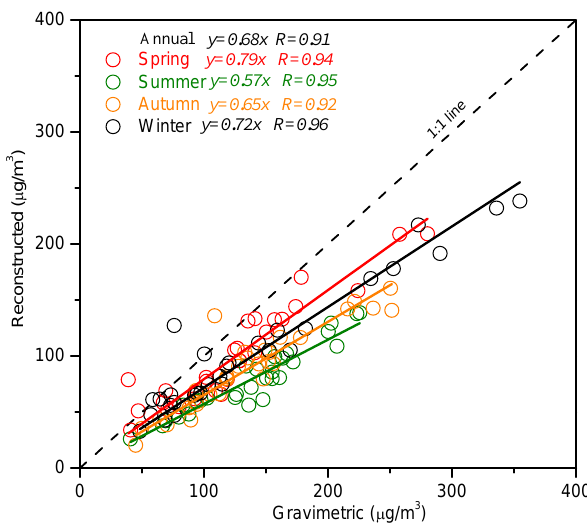
Figure 6 Fig. 6. Scatter plot showing the correlations between the PM 2 . 5 mass concentrations reconstructed from the chemical mass balance method and obtained from gravimetric measurement, which are pre- sented on a seasonal basis. Linear regression lines are shown with equations for the four-season period, along with the annual case.